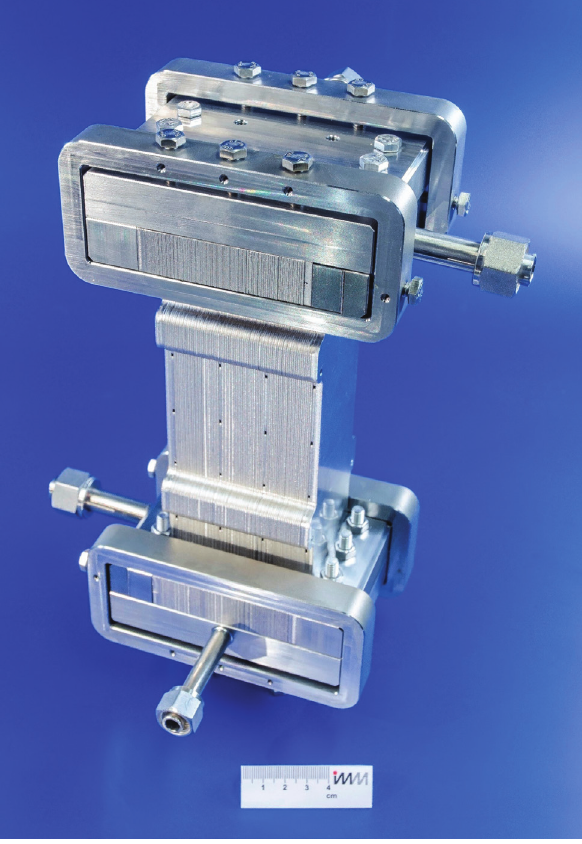
Figure 15 Vacuum brazed reaction module (improved version) assembled with distribution and sampling connectors.